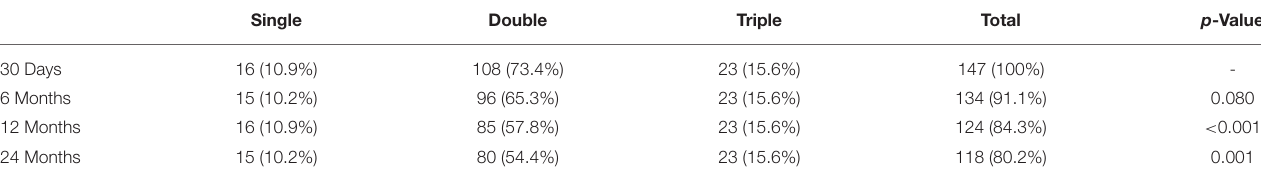
TABLE 5 | Relationship between branching number and vessel patency.